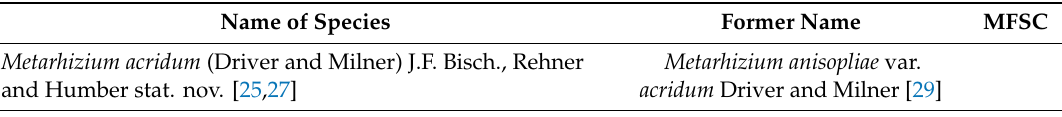
Table 1. Alphabetical species list of the Metarhizium genus. The first column presents the recent name of the taxon and references. The second column contains the most recent former name (and a reference, where applicable). X = Species of the M. flavoviride species complex